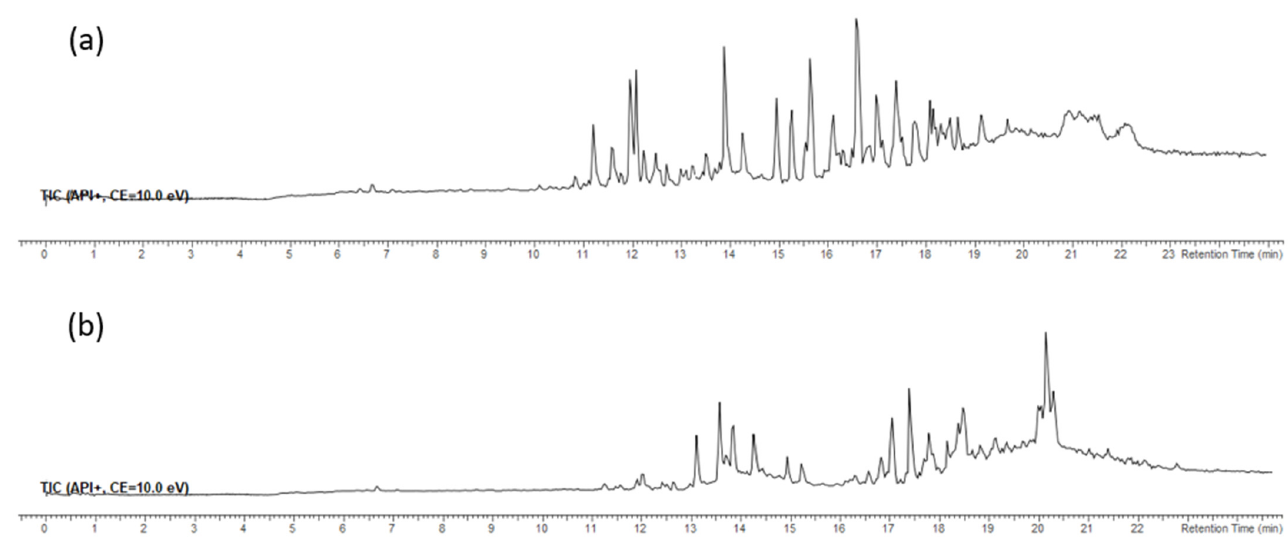
Figure 3. Total ion chromatogram (TIC) of the fractions ( a ) F3 and ( b ) F4.